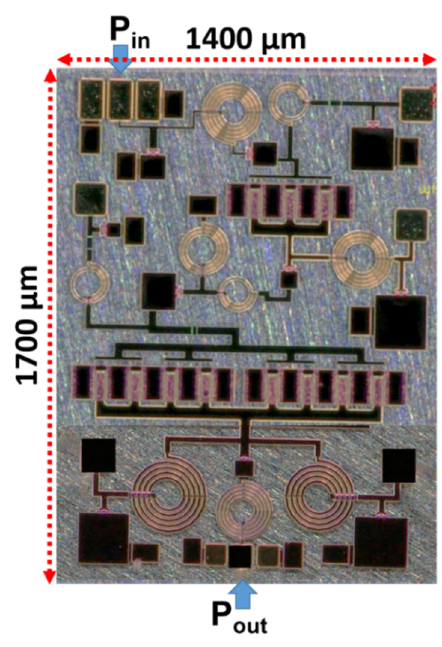
Figure 2. Image of power amplifier IC at 1600 × magnification captured (using Leica S8 APO equipment).